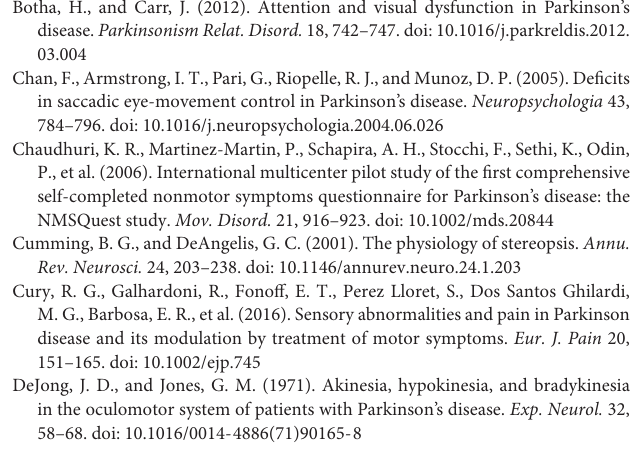
Supplementary Figure 1 | Screening stereopsis with 2D images. In the 2D pictures, two or three objects of uniform size were shown that are distributed in depth. The study participants were asked to provide a cue to the depth judging the relative sizes of the